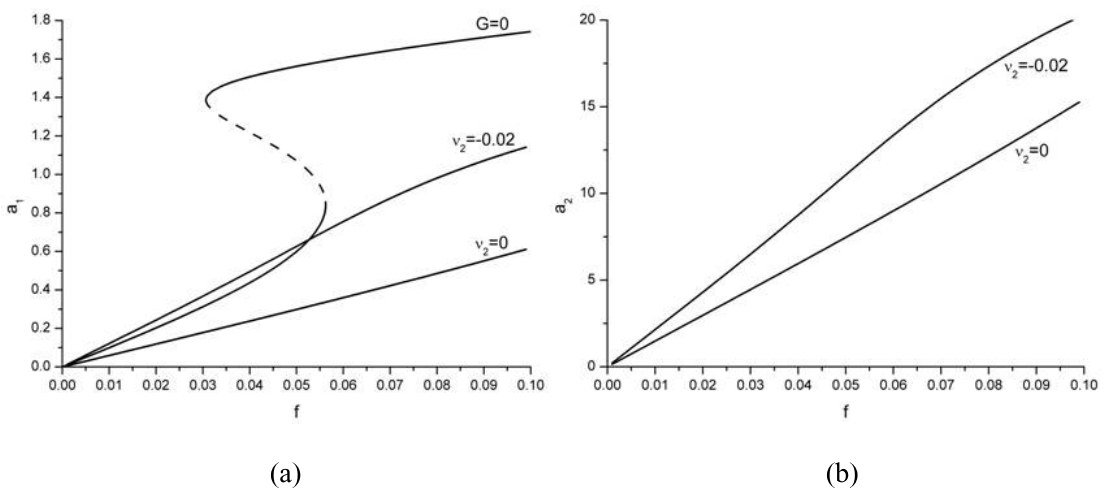
Fig. 14. Effect of detuning the absorber’s frequency on the force-response curves of (a) the plant and (b) the absorber when σ 1 = − 0 . 1 , G = 0 . 01 and ζ = 0 . 02 .